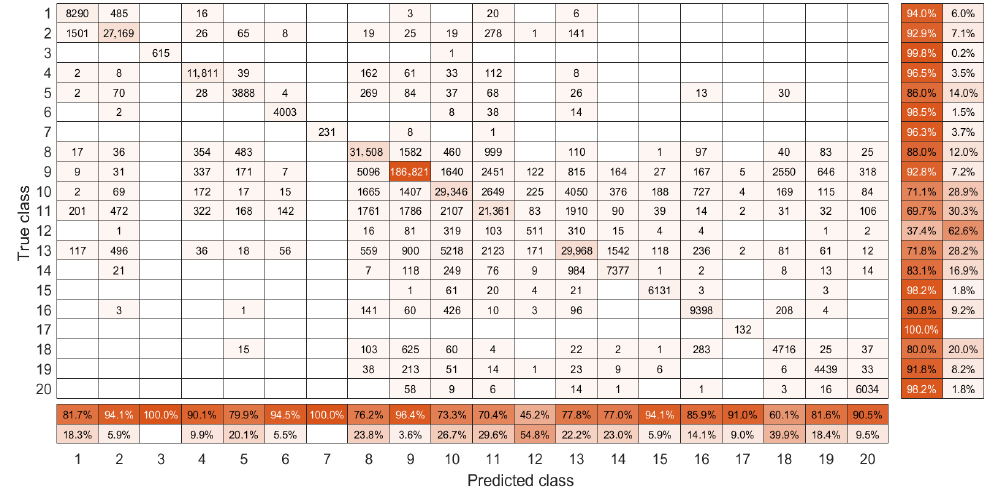
Figure 13. The confusion matrix of our model on the Houston 2018 dataset.